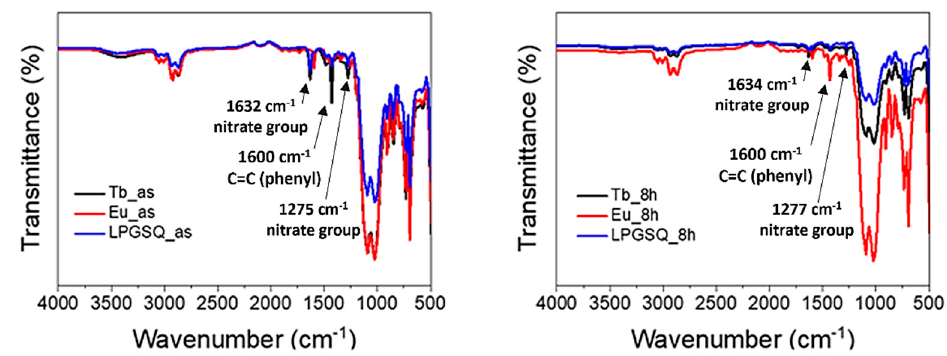
Figure 5. FT − IR spectra of as-prepared ( left ) and 8 h − cured LPGSQ64, LPGSQ64–Eu, and LPGSQ64– Tb films ( right ). The arrows demonstrate the newly emerged peaks identified in the LPGSQ film after lanthanide doping (nitrate groups) from 1632–1634 cm − 1 and 1275 − 1277 cm − 1 ; C=C bonds from phenyl groups present in both undoped and doped films from 1590–1600 cm − 1 .